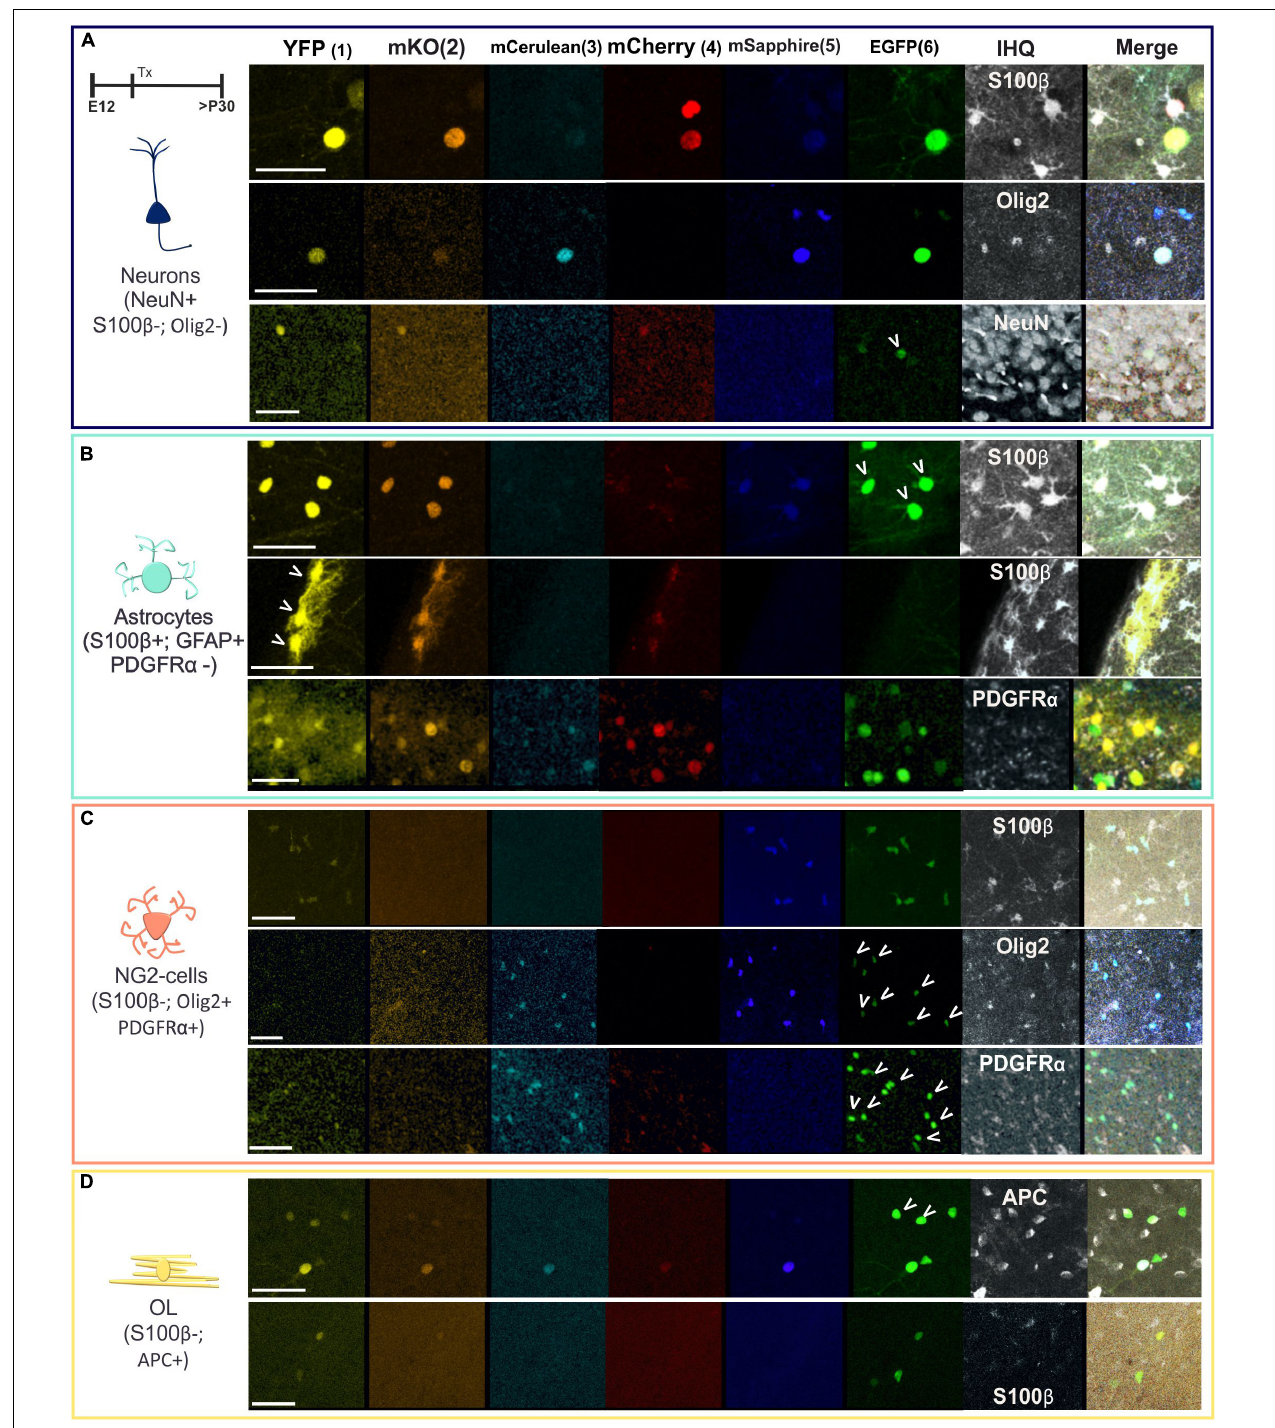
FIGURE 3 | Immuno-characterization of neural cells located in the piriform cortex. (A) Cells expressing NeuN but without S100 β and Olig2 expression were identified as neurons. (B) Positive cells to S100 β and GFAP but not to PDGFR α were classified as astrocytes. (C) NG2 cells expressed PDGFR α and Olig2 but not S100 β . (D) Oligodendrocytes were identified with APC. Arrowheads pointed the co-expression of UbC-(Gsx-2-PB)-StarTrack with the antibodies. The six reporter proteins of UbC-(Gsx-2-PB)-StarTrack acquired in separated channels of the confocal are the monomeric Turbo Sapphire fluorescent protein (mT-Sapphire: blue), monomeric Cerulean fluorescent protein (mCerulean: soft blue), enhanced green fluorescent protein (EGFP: green), yellow fluorescent protein (YFP: yellow), monomeric Kusabira Orange fluorescent protein (mKO: orange) and monomeric Cherry fluorescent protein (mCherry: red). The far red was used for the immunohistochemistry and is represented in gray. Schematic neurons are in blue; astrocytes in green; NG2 cells in soft red and OL in yellow. OL, oligodendrocytes. Scale bar: 25 µ m.